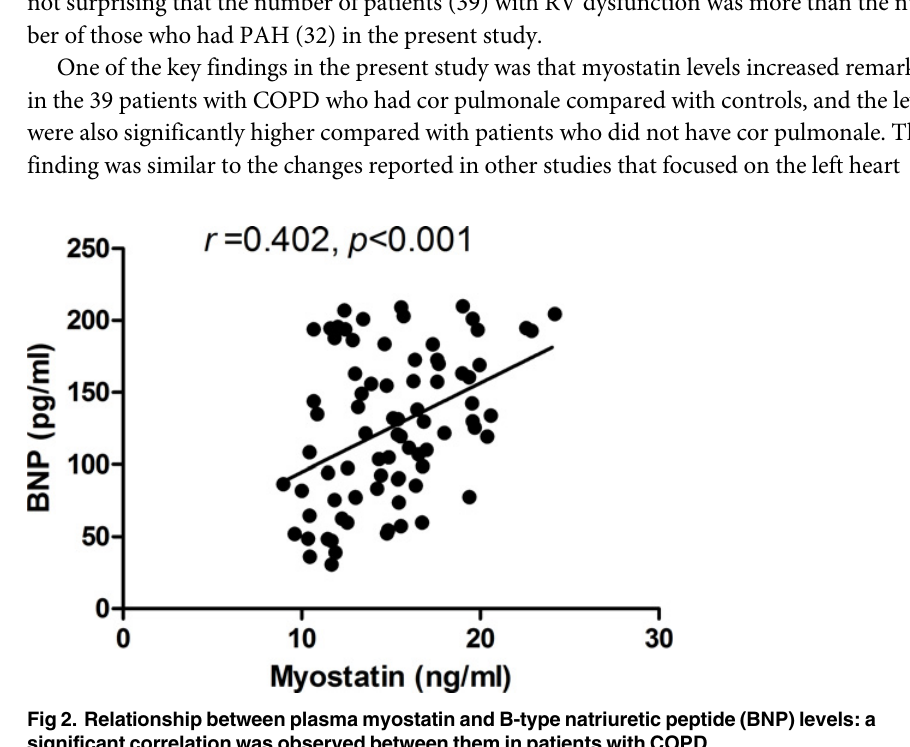
BNP- B-type natriuretic peptide, COPD-chronic obstructive pulmonary disease, LVEF-left ventricular ejection fraction, FAC-fractional area change, RAD-right atria diameter, RVD-right ventricular diameter, RVMPI-right ventricular myocardial performance index, RVWT-right ventricular free wall thickness. SPAP- systolic pulmonary artery pressure, TAPSE-tricuspid annular plane systolic excursion.